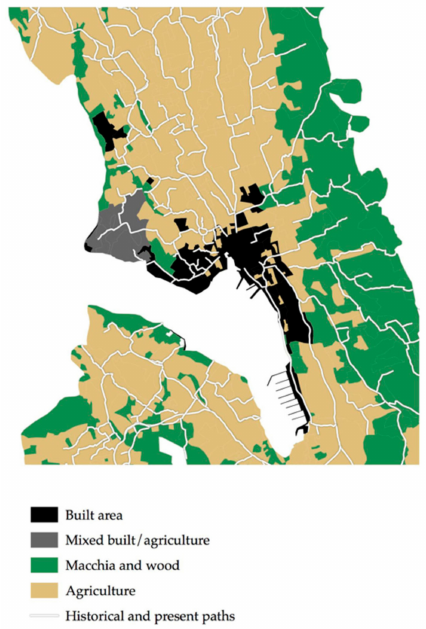
Figure 15. The structural interconnection of the town of Cres with its agricultural zone is noted in the network of dry stone wall lined pathways.